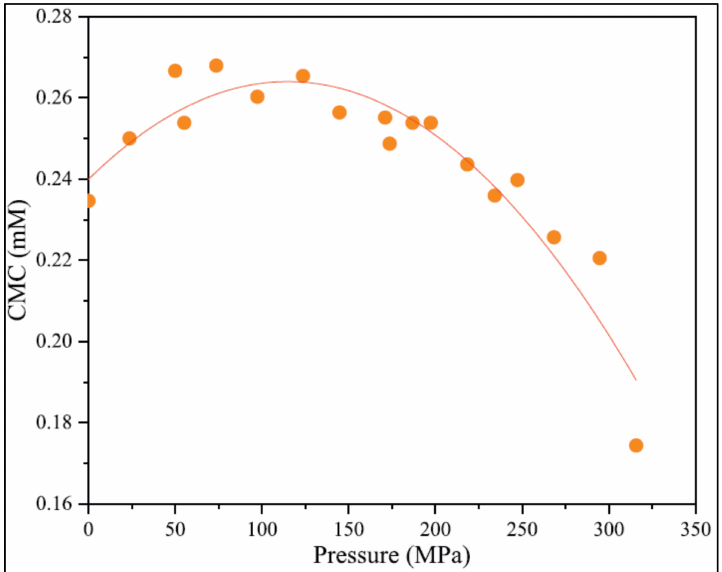
Figure 18. Effect of pressure on CMC value (Reprinted with the permission from Zhou et al. [24]). Copyright 2020, Published by Elsevier